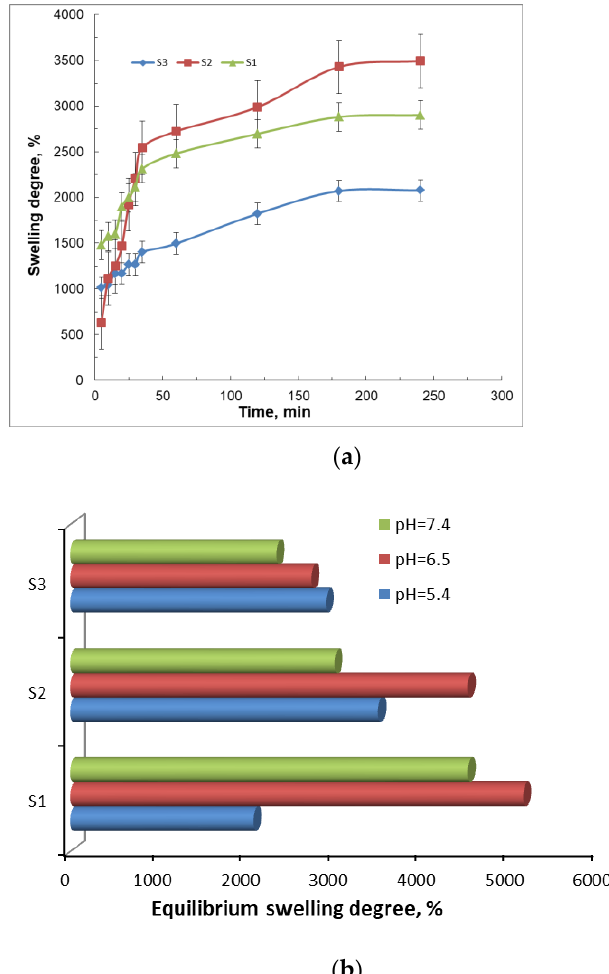
Figure 8. The swelling behavior of the gels as a function of time ( a ) and equilibrium swelling degree at different pH values ( b ).